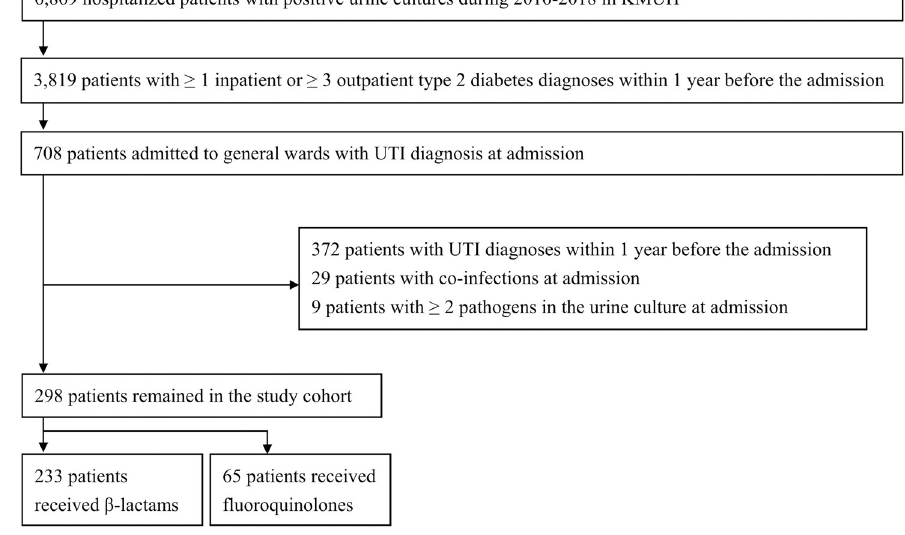
Fig 1. Flowchart of the study. KMUH: Kaohsiung Medical University Hospital; UTI: urinary tract